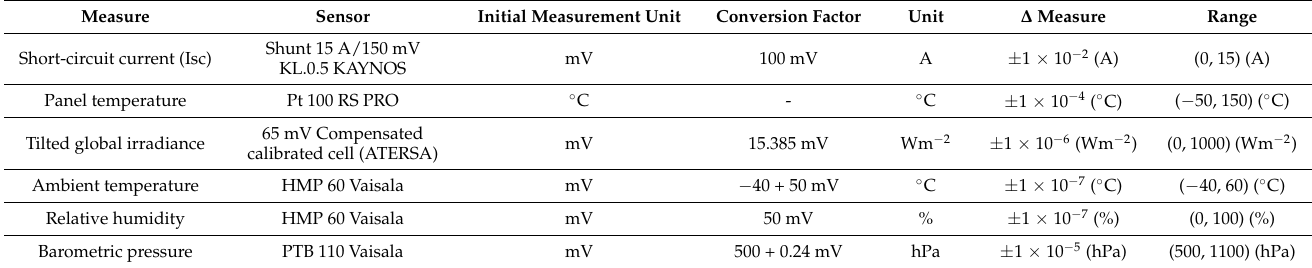
Table 1. Metrological analysis of